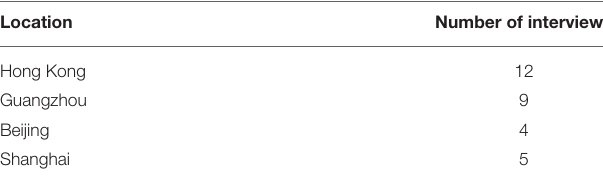
TABLE 1 | Interviews in Hong Kong and mainland China. Location Number of interviews